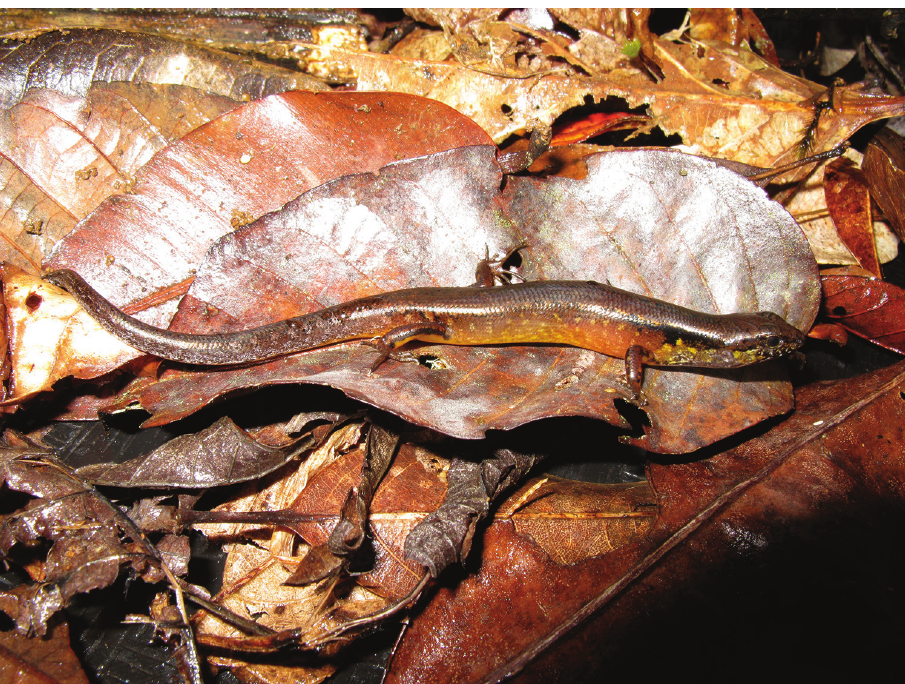
Figure 59. Parvoscincus mindanensis (specimen not collected) Mt. Balatukan, Municipality of Gingoog, Misamis Oriental Province. Photo: